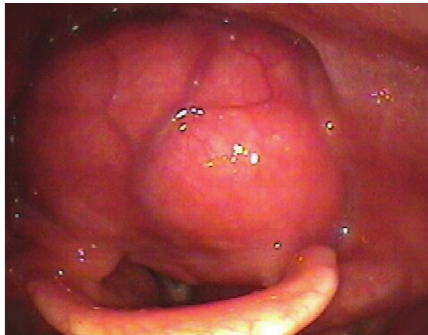
Figure 1: Video stroboscopy image of the postcricoid SFT demon- stratingalargesofttissuemassinthepostcricoidregionencroaching the laryngeal